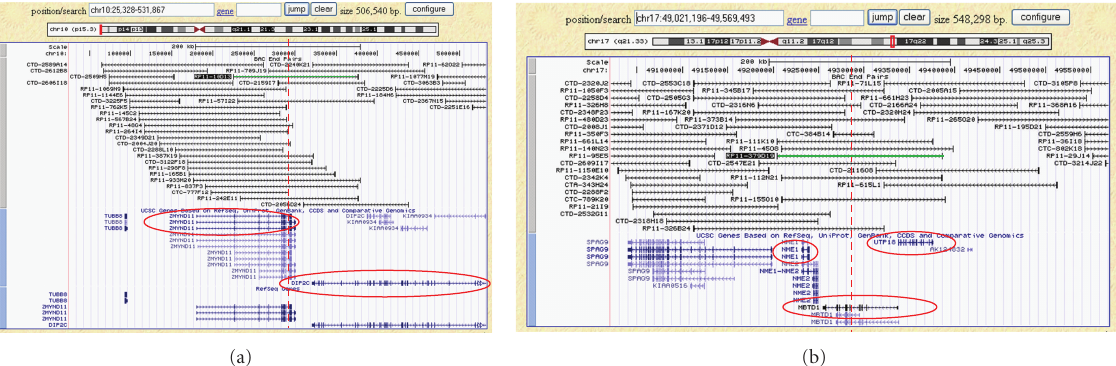
Figure 1: Identification of breakpoints involved in a newly recognized recurrent translocation, t(10;17)(p15;q21). (a) Representation of the breakpoint (dotted line) on the short arm of chromosome 10 for both patients by FISH with BACs. Applied BAC clones are bordered; candidate genes are surrounded. (b) Representation of the breakpoint (dotted lines) on the long arm of chromosome 17 for both patients by FISH with BACs. Applied BAC clones are bordered; candidate genes are surrounded.